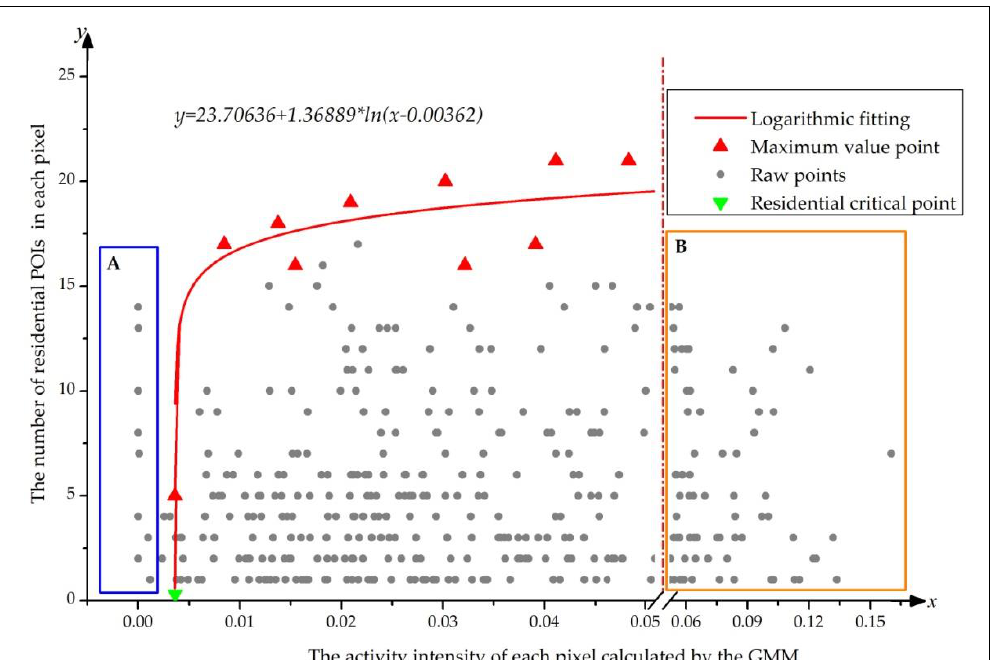
Figure 7. Quantitative analysis of POI and activity intensity data. Part A shows the pixels with a low activity intensity (close to zero) and large number of POIs. Part B highlights the pixels with a high activity intensity and few POIs.